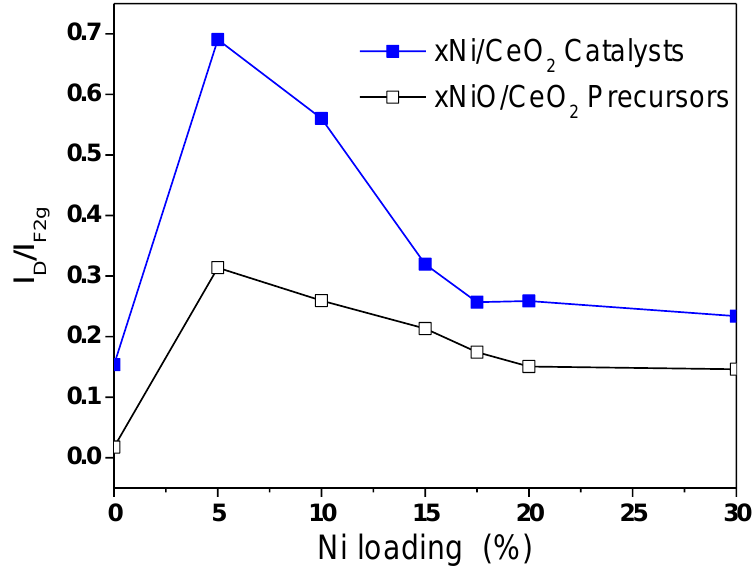
Figure 5. I D /I F2g ratios for the xNiO/CeO 2 precursors and reduced xNi/CeO 2 catalysts. As shown in Figure 5, compared with the xNiO/CeO 2 samples, the I D /I F2g ratios for the xNi/CeO 2 catalysts increased significantly after reduction, indicating that the oxygen vacancy concentrations on the surface of the xNi/CeO 2 catalysts increased obviously after H 2 reduction. The oxygen vacancy increments of 5Ni/CeO 2 and 10Ni/CeO 2 were significantly larger than those of other catalysts with higher Ni loading, which suggests that lower Ni content was beneficial to the formation of oxygen vacancies on the surface of the catalyst. When the loaded content of Ni was low, Ni species and CeO 2 were in close contact and interacted strongly each other, which could have promoted the reduction of the CeO 2 surface and facilitated the formation of oxygen vacancies on the surface. However, as Ni loading increased, the active Ni species began to aggregate and cover the surface of CeO 2 , which weakened the Ni–CeO 2 interaction and inhibited the reduction of CeO 2 surface. In order to further study the effect of Ni content on the surface species of Ni/CeO 2 , five samples of CeO 2 , 5Ni/CeO 2 , 10Ni/CeO 2 , 17.5Ni/CeO 2 , and 30Ni/CeO 2 were char- acterized by the XPS technique. Figure 6A shows the Ce 3d XPS spectra of the catalyst. The peak of Ce is deconvolved into five groups of characteristic peaks according to the literature [28,29]. The three characteristic peaks labeled u and v, u” and v”, and u”’ and v”’ belong to the XPS peaks of 3d 1/2 and 3d 5/2 of Ce 4+ 3d, while the two characteristic peaks of u’ and v’ and u 0 and v 0 belong to the 3d 1/2 and 3d 5/2 of Ce 3+ 3d. Compared with pure CeO 2 , the XPS peak of Ce 4+ in the 5Ni/CeO 2 catalyst moved slightly towards the high-energy direction, indicating that the strong interaction between Ni and CeO 2 changed the electronic configuration of Ce on the surface. Similar phenomena were observed